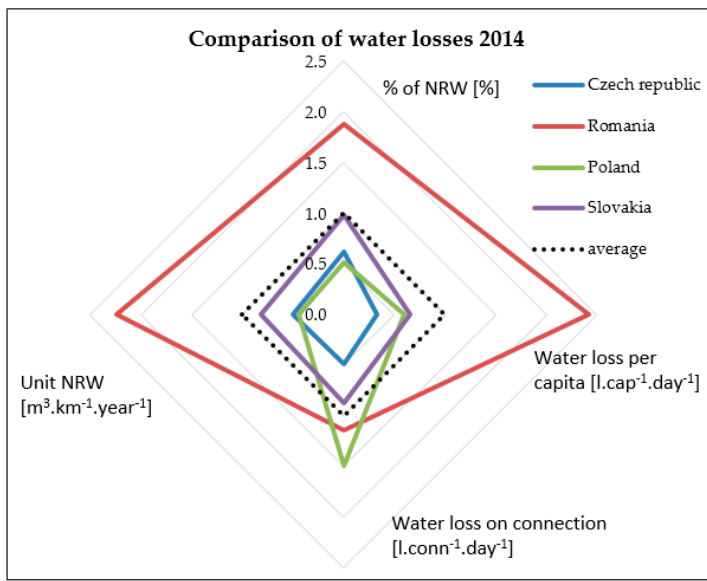
Figure 3. Percentage of NRW for years 2010–2015.